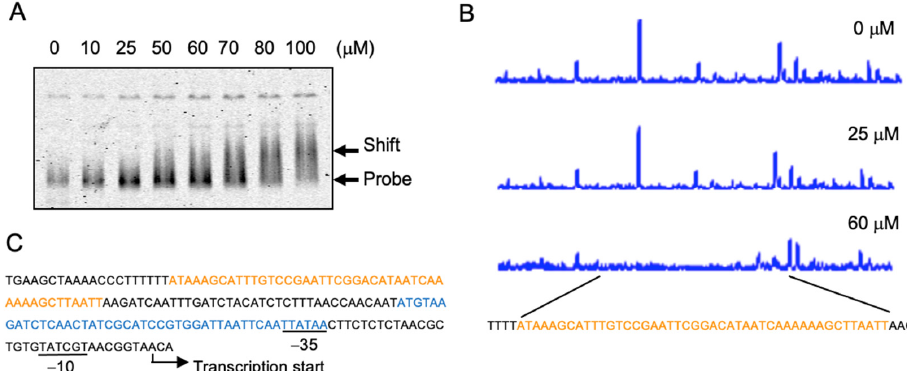
Figure 6. YgaV binding to the katG promoter: ( A ) Gel mobility shift analysis of DTT-treated apo-YgaV to the fluorescent-labeled katG promoter DNA. The protein-DNA mixtures were separated by 5% PAGE. After electrophoresis, gels were analyzed using an image analyzer; ( B ) DNase I footprint analysis of DTT-reduced apo-YgaV with the katG promoter DNA. Regions corresponding to the DNase I protection regions are shown in red. ( C ) The DNA sequence of the katG promoter region. OxyR and YgaV-binding sites are indicated by blue and red, respectively. The transcription start site and the RNA polymerase recognition sites ( − 10 and − 35) are also